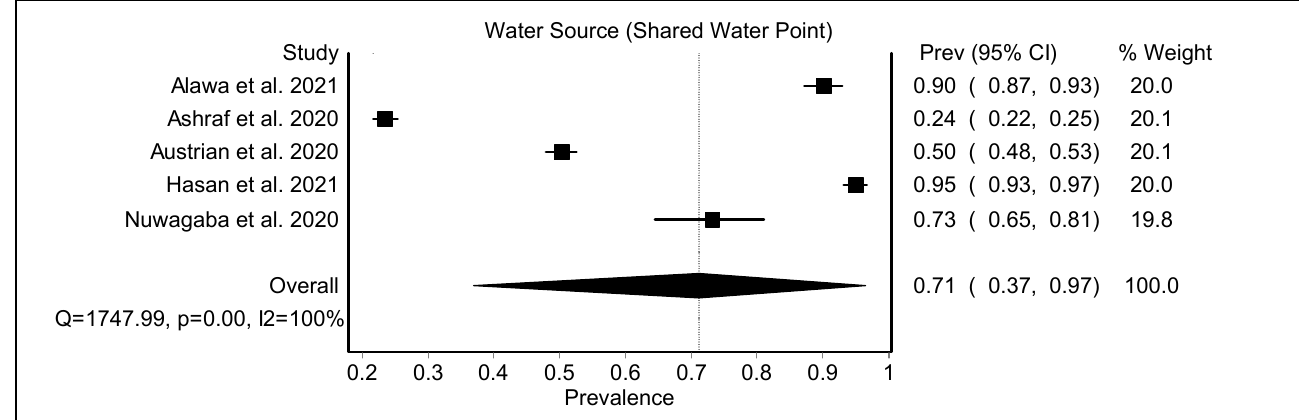
Figure 2. The pooled prevalence of shared water points for water sources among the urban poor [25,48,49,51,56].